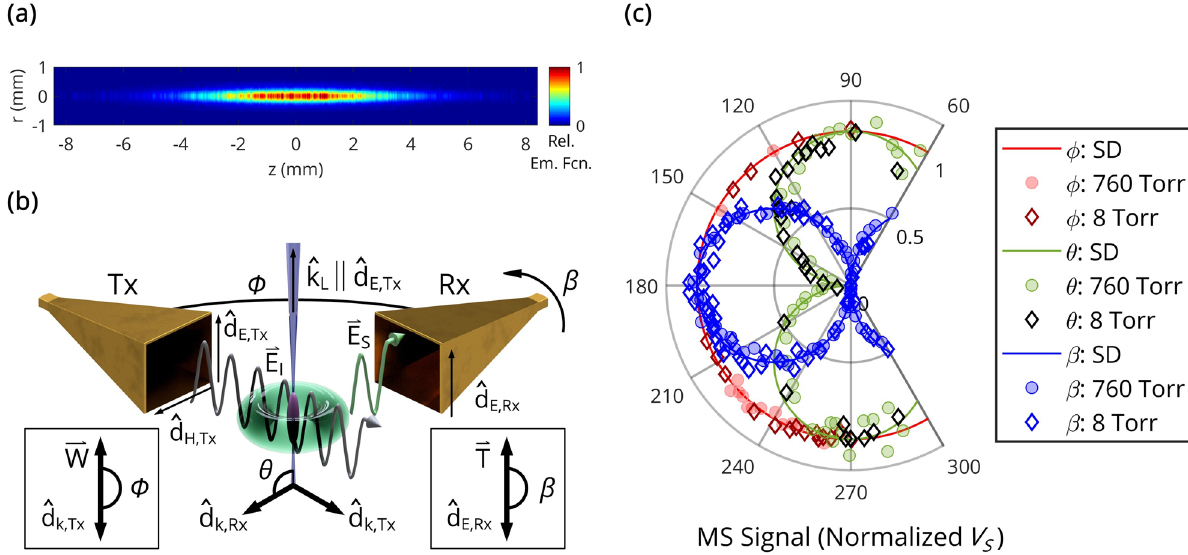
Figure 2. Coherent microwave scattering from short, thin weakly-ionized plasmas. ( a ) Relative emission function (representative of an axisymmetric electron number density) of the laser-induced plasma at a background pressure of 760 Torr, calculated from an Abel-inversion of the corresponding ICCD image (gate width 100 ns, 250 accumulations). ( b ) Illustration of in-phase coherent microwave scattering and short-dipole- like far-field radiation behavior. ( c ) Short dipole (SD, line) and experimental f = 10.5 GHz plasma scattered (8 and 760 Torr, scatter) radiation patterns at t = 5 ns for a Tx/Rx distance of 10 cm. The microwave scattering signal (normalized V S ) is proportional to the scattered E-field amplitude, and angular variation is based on default positions φ = 270°, θ = 90°, and β =